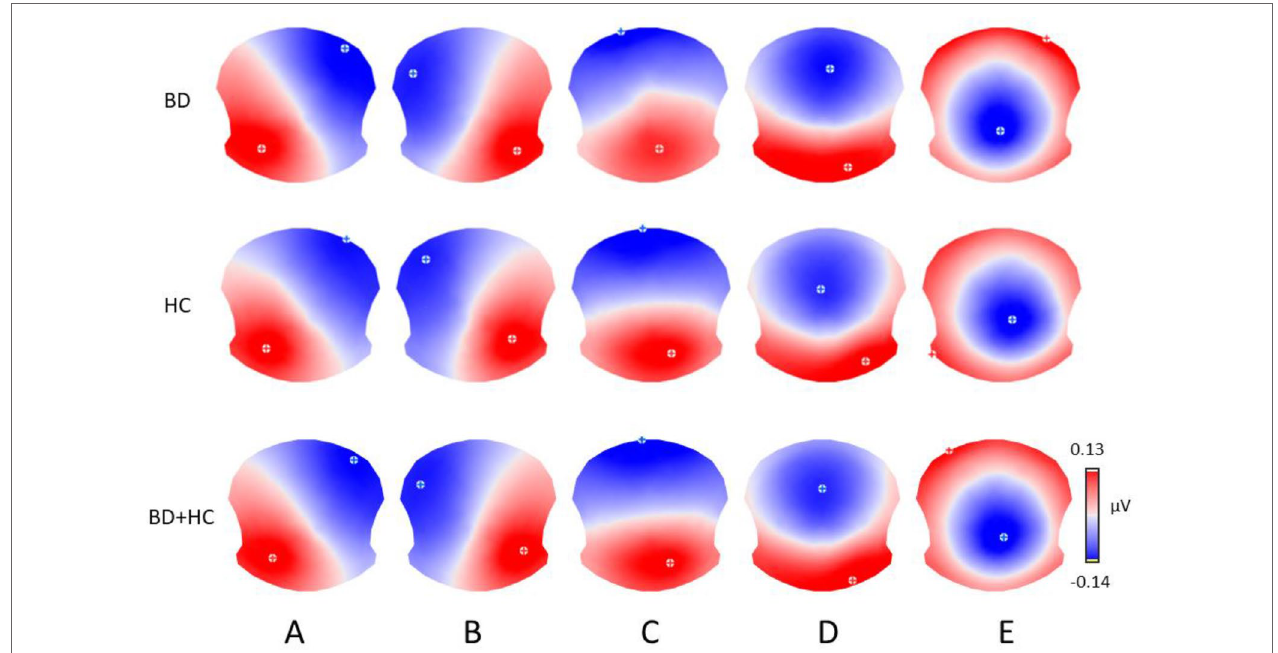
FIgURE 1 | The five microstate topographies (A – E) identified in the group clusterings across patients (BD) and healthy controls (HC) and in the global clustering across all subjects (BD+HC). Note that similar five dominant microstate topographies were identified in all three